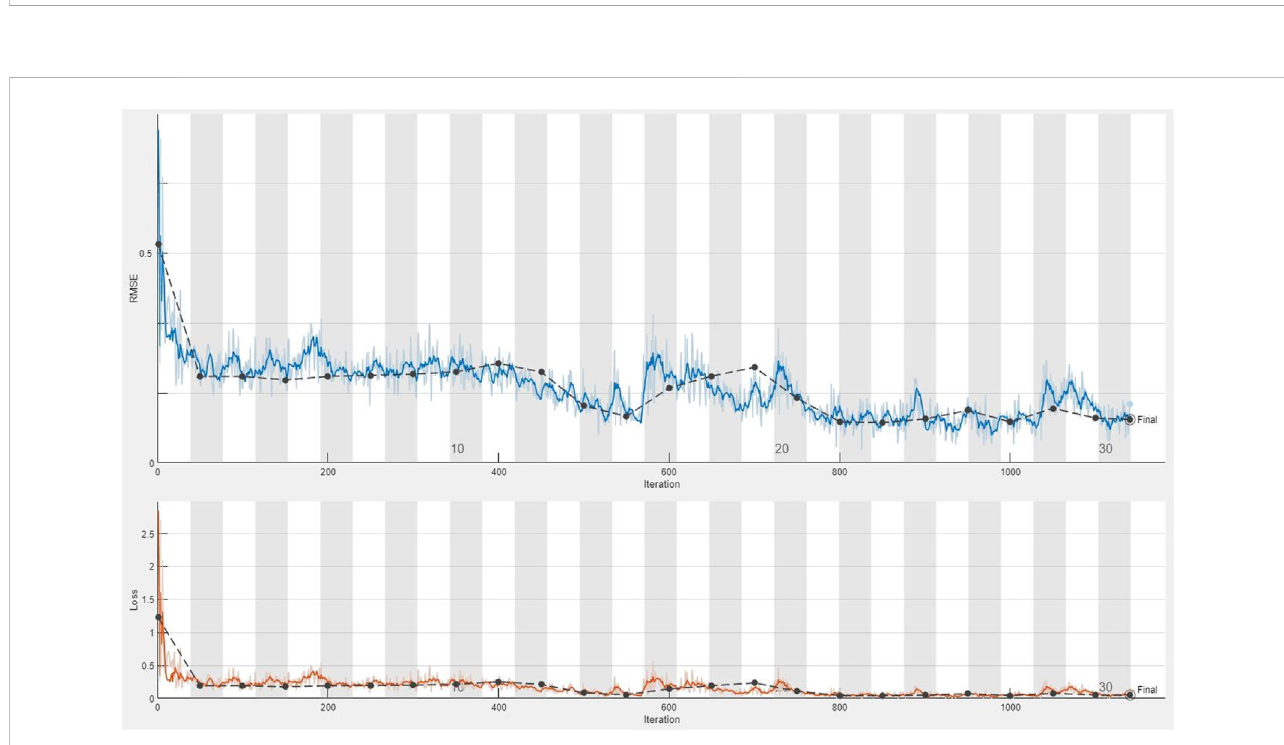
FIGURE 10 PlotofthethirdtrainingofthedatasetapplyingtheCDLnetworkforcalculatingthelossvalueandRMSEparameter fromthethirdstageregimentationof the second group (Ag – Cd – As –